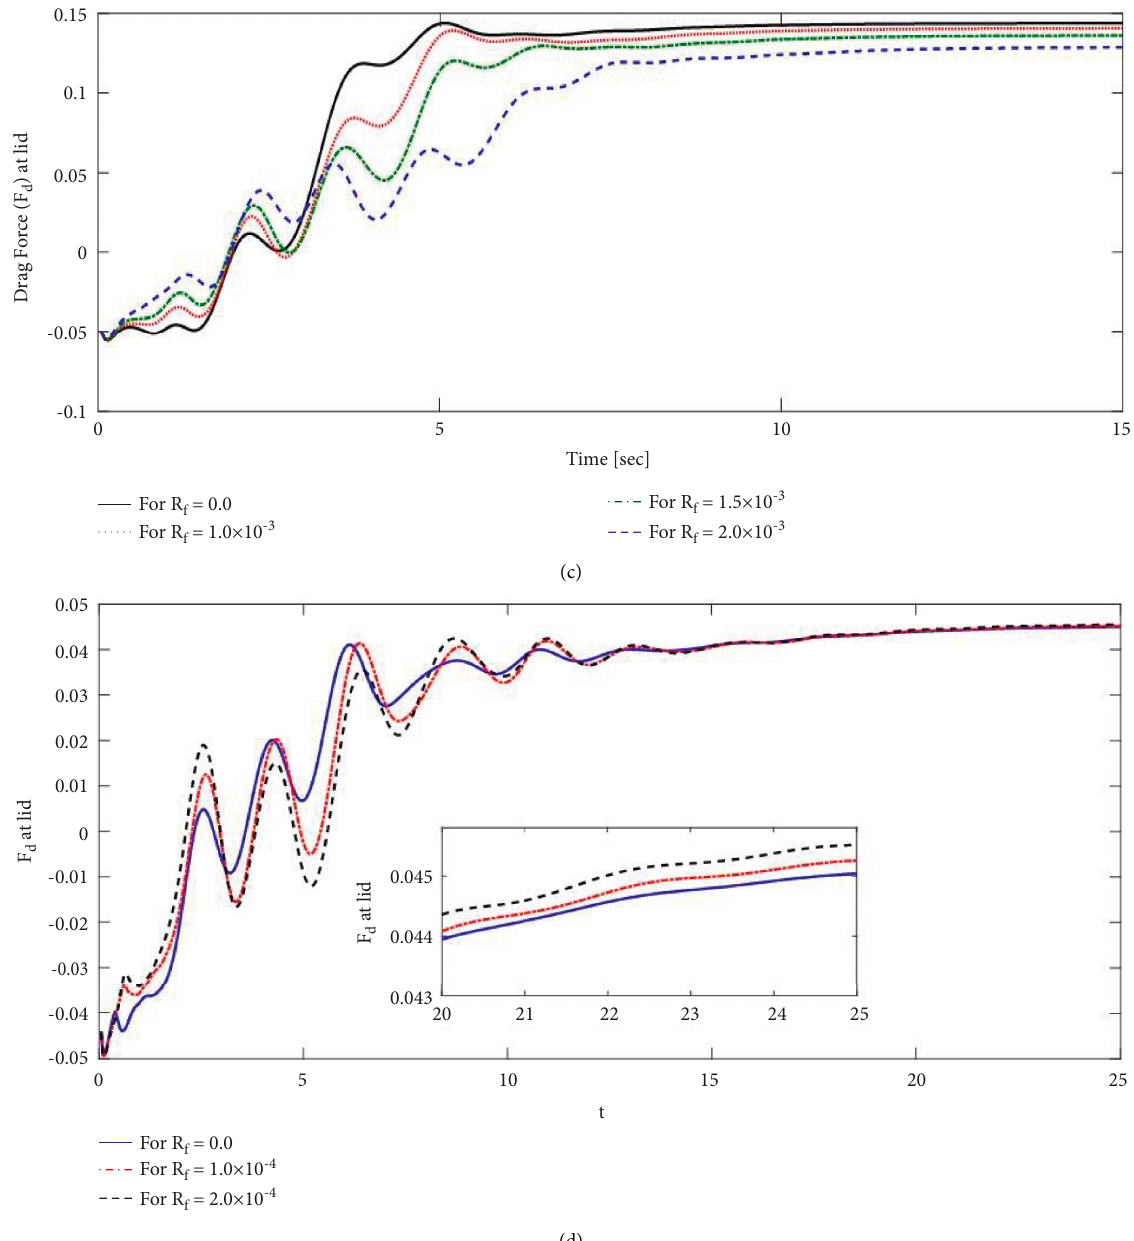
Figure 6: Drag force at the lid surface with L � 0 . 25 and varying values of R for Re �